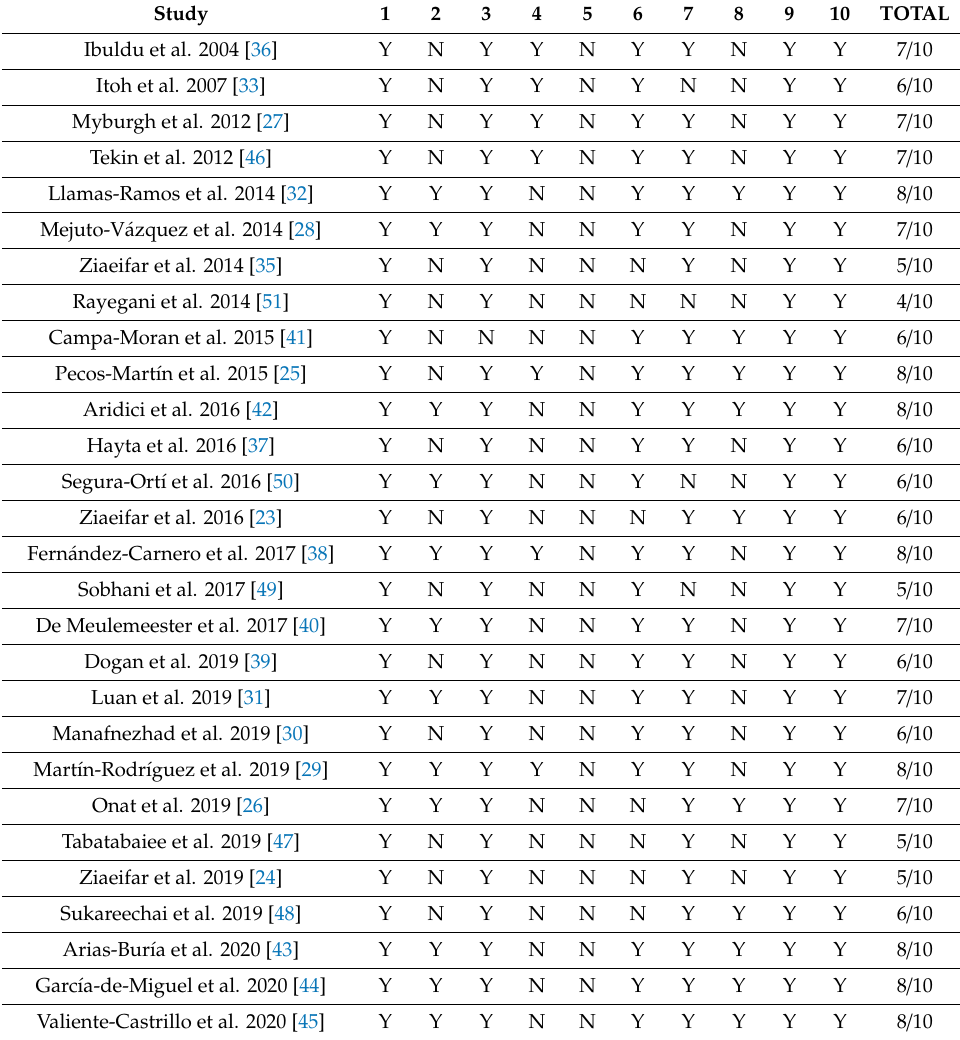
Table 4. Methodological quality score (Physiotherapy Evidence Database (PEDro) scale) of randomized clinical